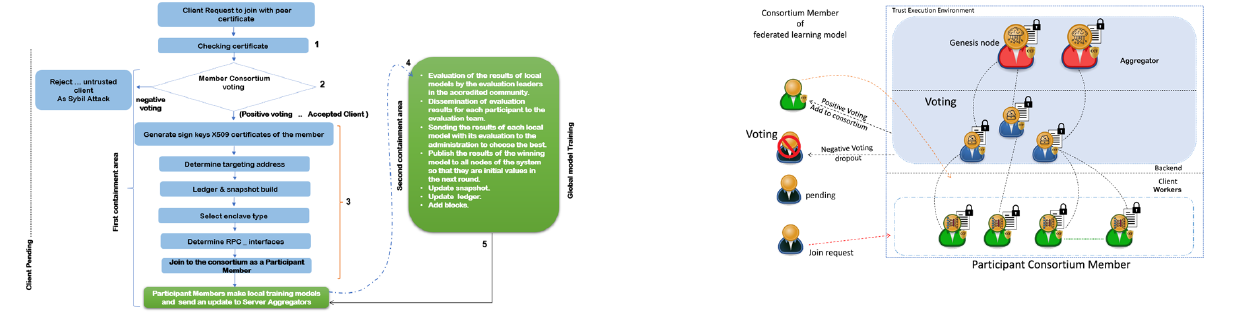
Fig. 3. first containment area by CCF checkpoint